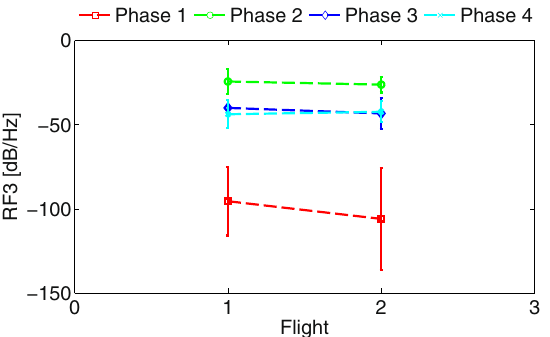
Figure 3. Flight type (1–navigation included, 2–navigation excluded) against flight phase (1–before engine failure, 2–engine failure, 3–glide, 4–approach and landing).